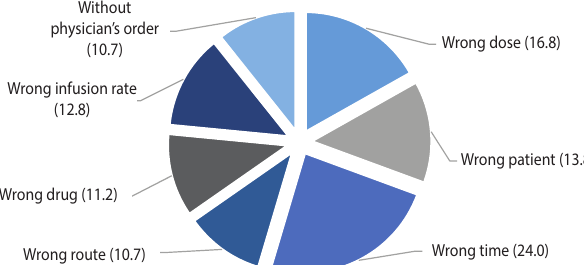
Figure 1. Proportion of different types of medication errors (MEs) Figure 1 : Proportion of different types of MEs as a percentage of total MEs among as a percentage of total MEs among nurses in Kermanshah, west of nurses in Kermanshah, west of Iran, 2016 (n=500): Nurse’s own assessment Iran, 2016 (n=500): nurse’s own assessment. Table 2. Nurses’ assessments of the main causes of MEs among nurses in Kermanshah, western Iran (n=500) Categories